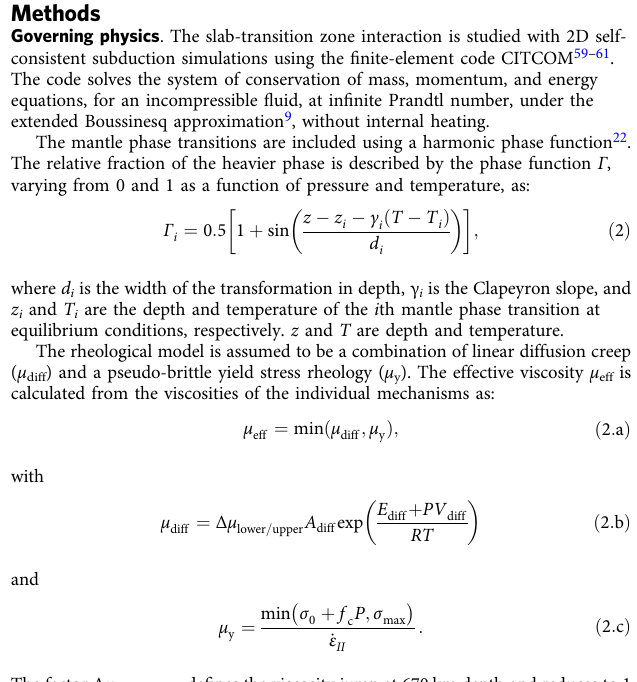
Table 1 List of parameters Symbol Global